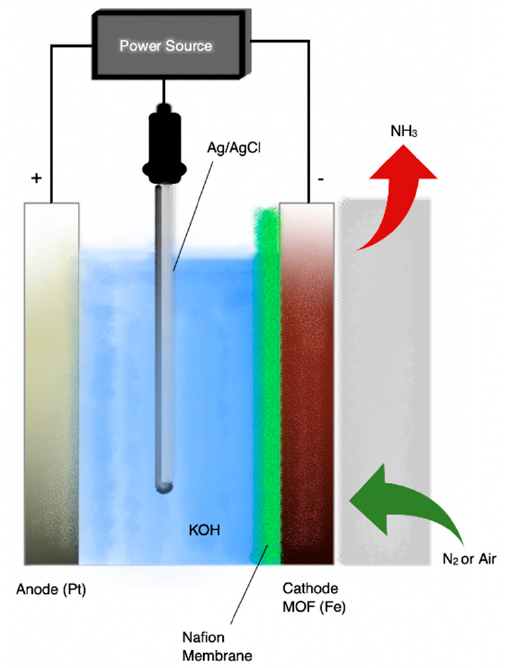
Figure 7. Schematic diagram of the KOH cell where NH 3 production was catalyzed by metal–organic- frameworks (MOFs) of Fe, Cu, and Co. Redrawn from [49].